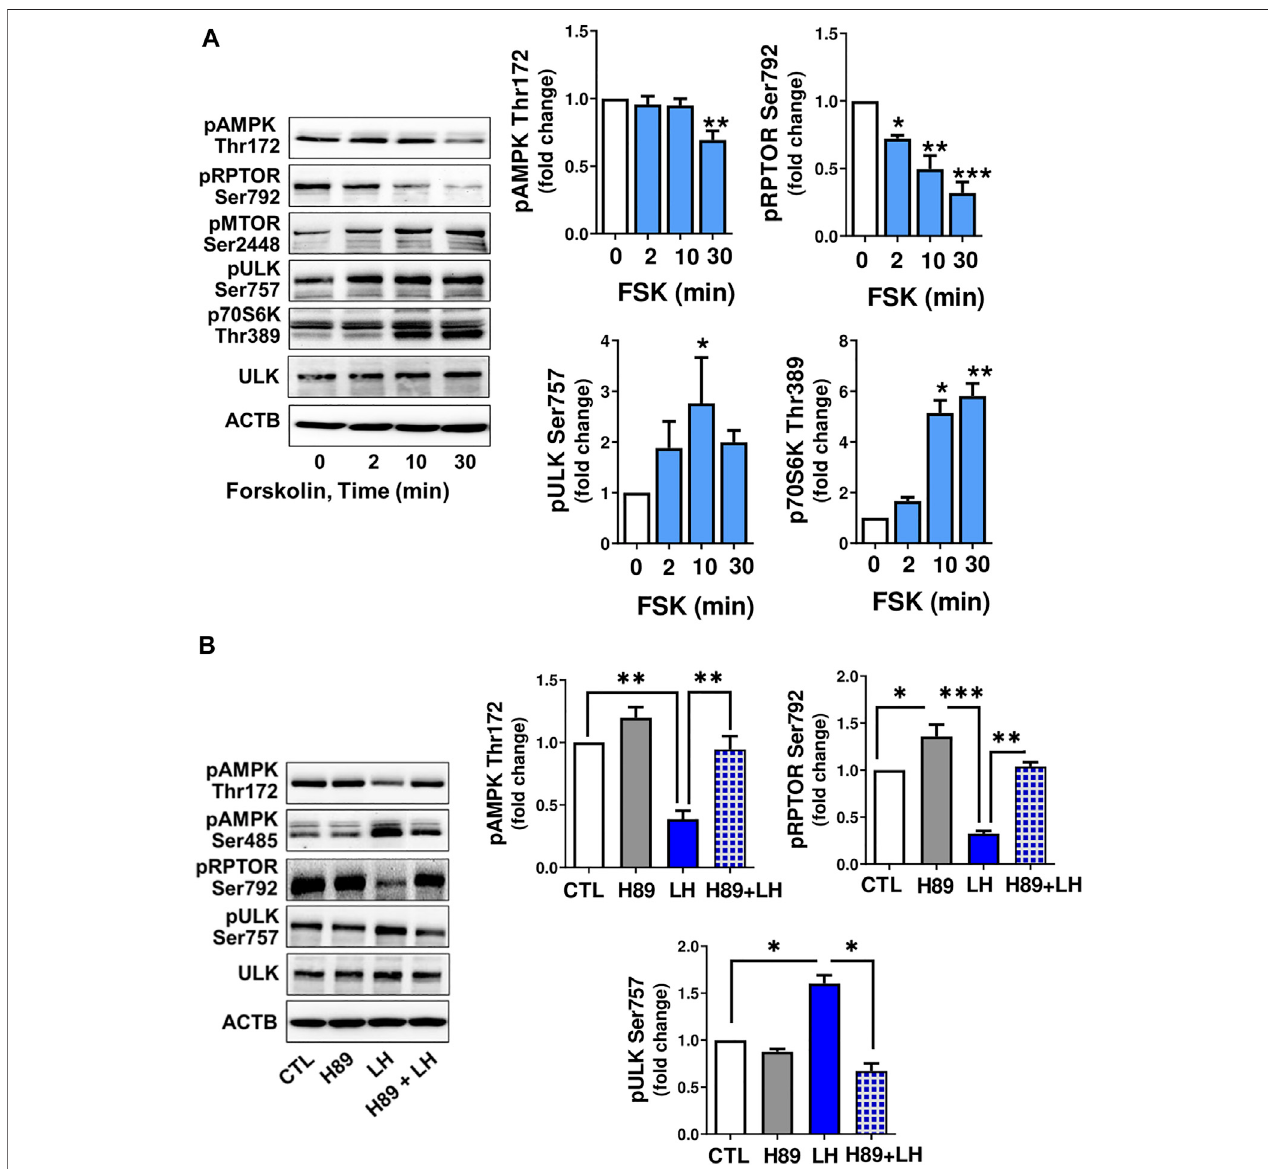
FIGURE5| LH/PKAsignalingaffectsphosphorylationofproteinsinvolvedinMTORsignalingorautophagyinitiation. (A) Smalllutealcellsweretreatedwithforskolin (FSK; 10 µM) for 2 – 30 min. Western blot analysis was performed to evaluate phosphorylation of AMPK α (Thr172 and Ser485), RPTOR (Ser792), ULK1 (Ser757) and p70S6K (Thr389). (B) Small luteal cells were pretreated with PKA inhibitor H89 (30 μ M) for 45 min and then treated with LH (10 ng/ml) for 10 min. Representative blots present phosphorylation of AMPK α (Thr172 and Ser485), RPTOR (Ser792), ULK1 (Ser757), p70S6K (Thr389) and total ULK1. Bar graphs show average fold changes ± SEM from 3 to 5 separate experiments. Data were normalized to β -actin. Statistical analysis was performed using one-way ANOVA test for repeated measurements and Bonferroni post hoc test. Signi fi cant differences are indicated with asterisks *, ** and *** representing p < 0.05, p < 0.01 and p < 0.001.